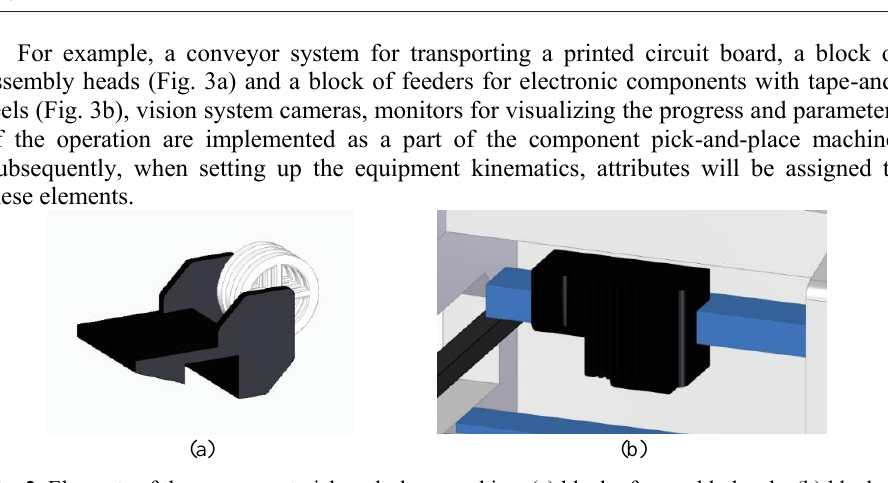
Fig. 3 . Elements of the component pick-and-place machine: (a) block of assembly heads; (b) block of tape feeders.